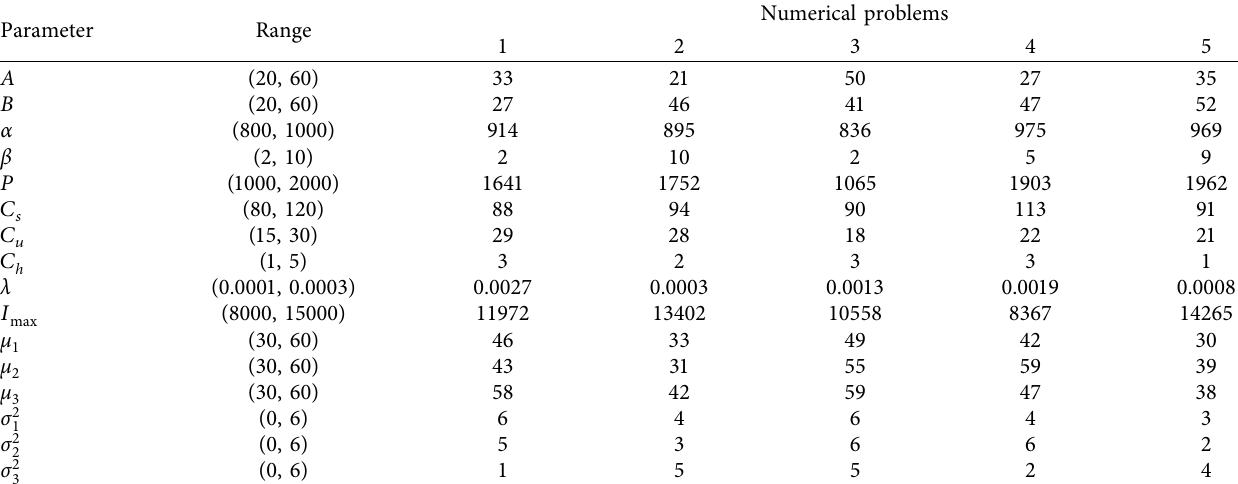
Table 2: Ranges of model parameters and generated parameter values.